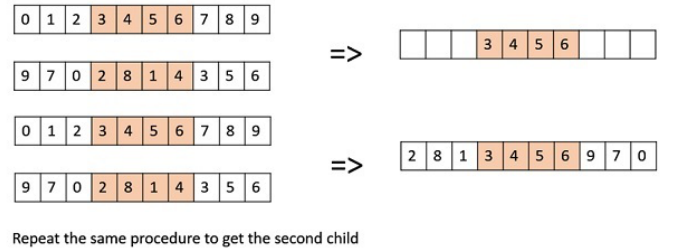
Fig. 3 Schematic diagram of single-point crossover